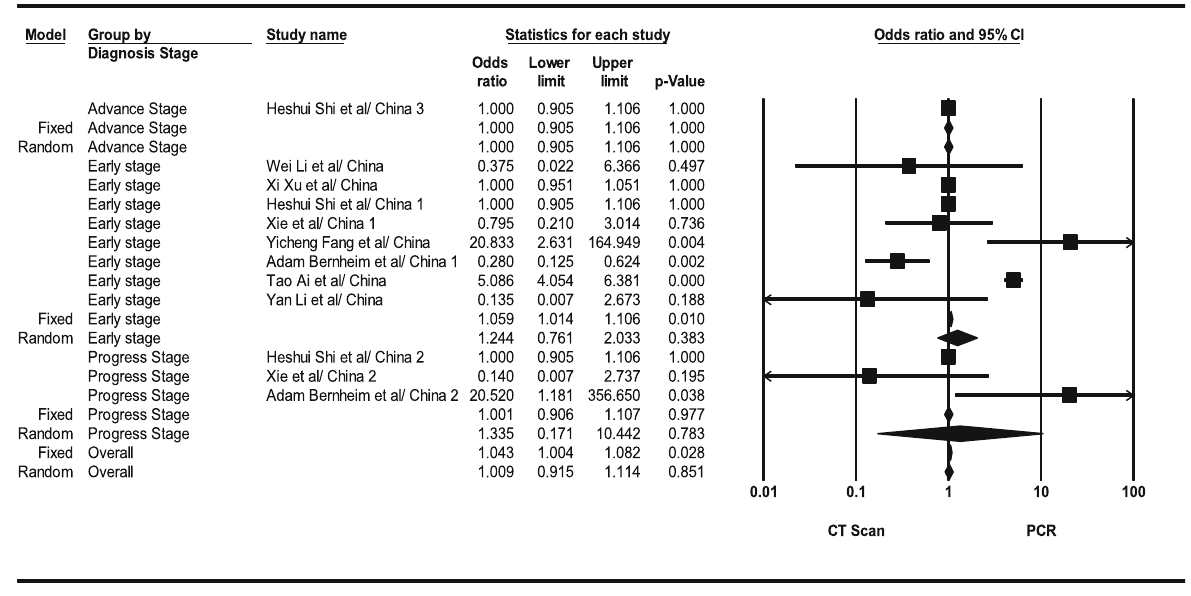
Fig. 11 Results of GGO in CT scan of